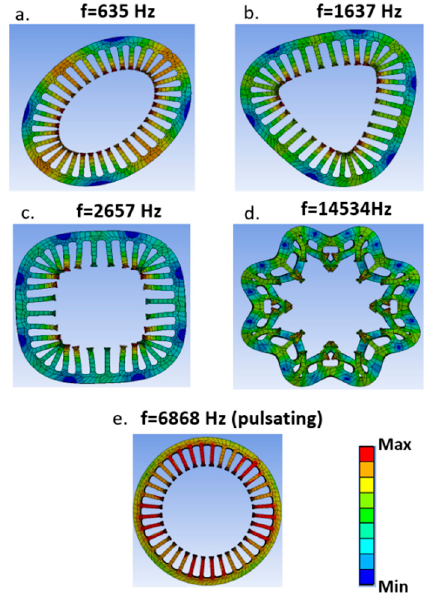
Figure 6. Front view of the 3D numerical model of the stator stack; calculated natural frequencies and their corresponding modal shapes : ( a ) m = 2, ( b ) m = 3, ( c ) m = 4, in ( d ) m = 8 and ( e ) m = 0 (pulsating mode). The normalized total deformations are indicated from minimum (blue color) to maximum (red color).